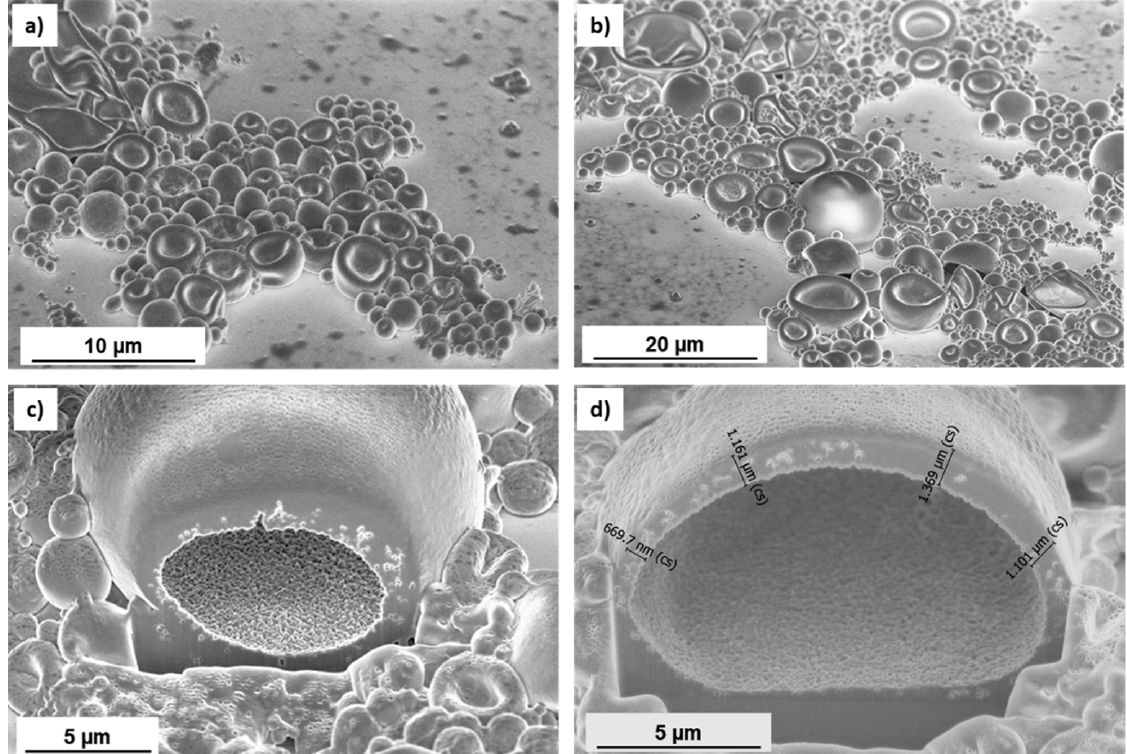
Figure 4. Focused ion beam (FIB)-SEM images of the PdNPs/PEG200@PU MCs before etching process ( a , b ) and after etching ( c , d